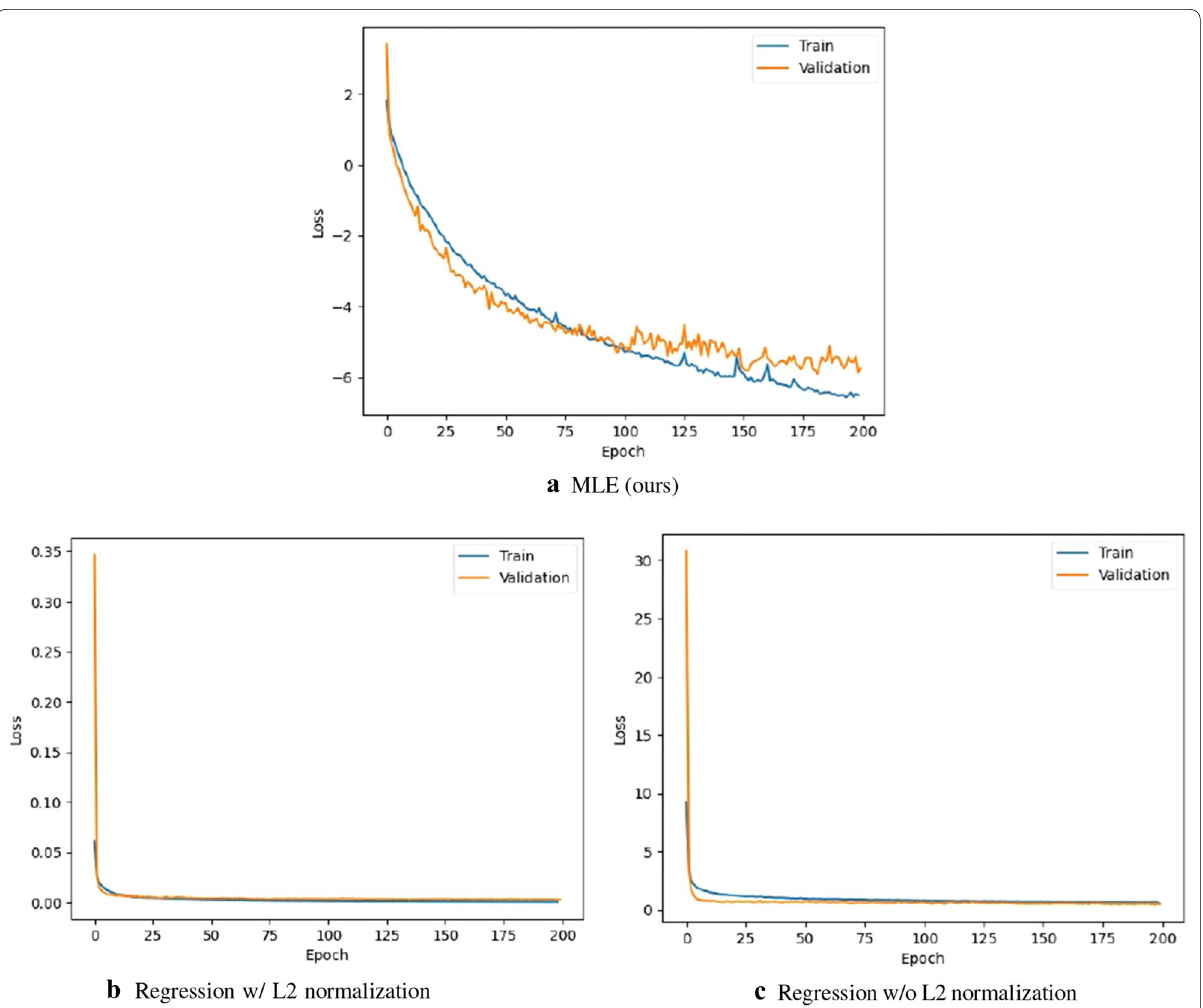
Fig. 7 Loss plotting. It is noted a loss functions of the MLE model and one of the regression models are difference. Therefore, their values can not be simply compared